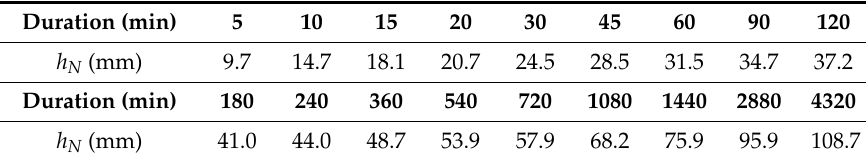
Table 1. Precipitation intensities h N of different event durations for a 5-year event at Schöneck i.V. (data: [44]).